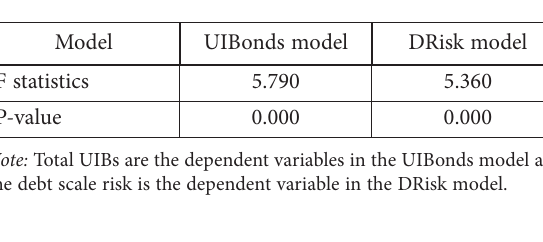
Table 2. F test of mixed- and fixed-effect